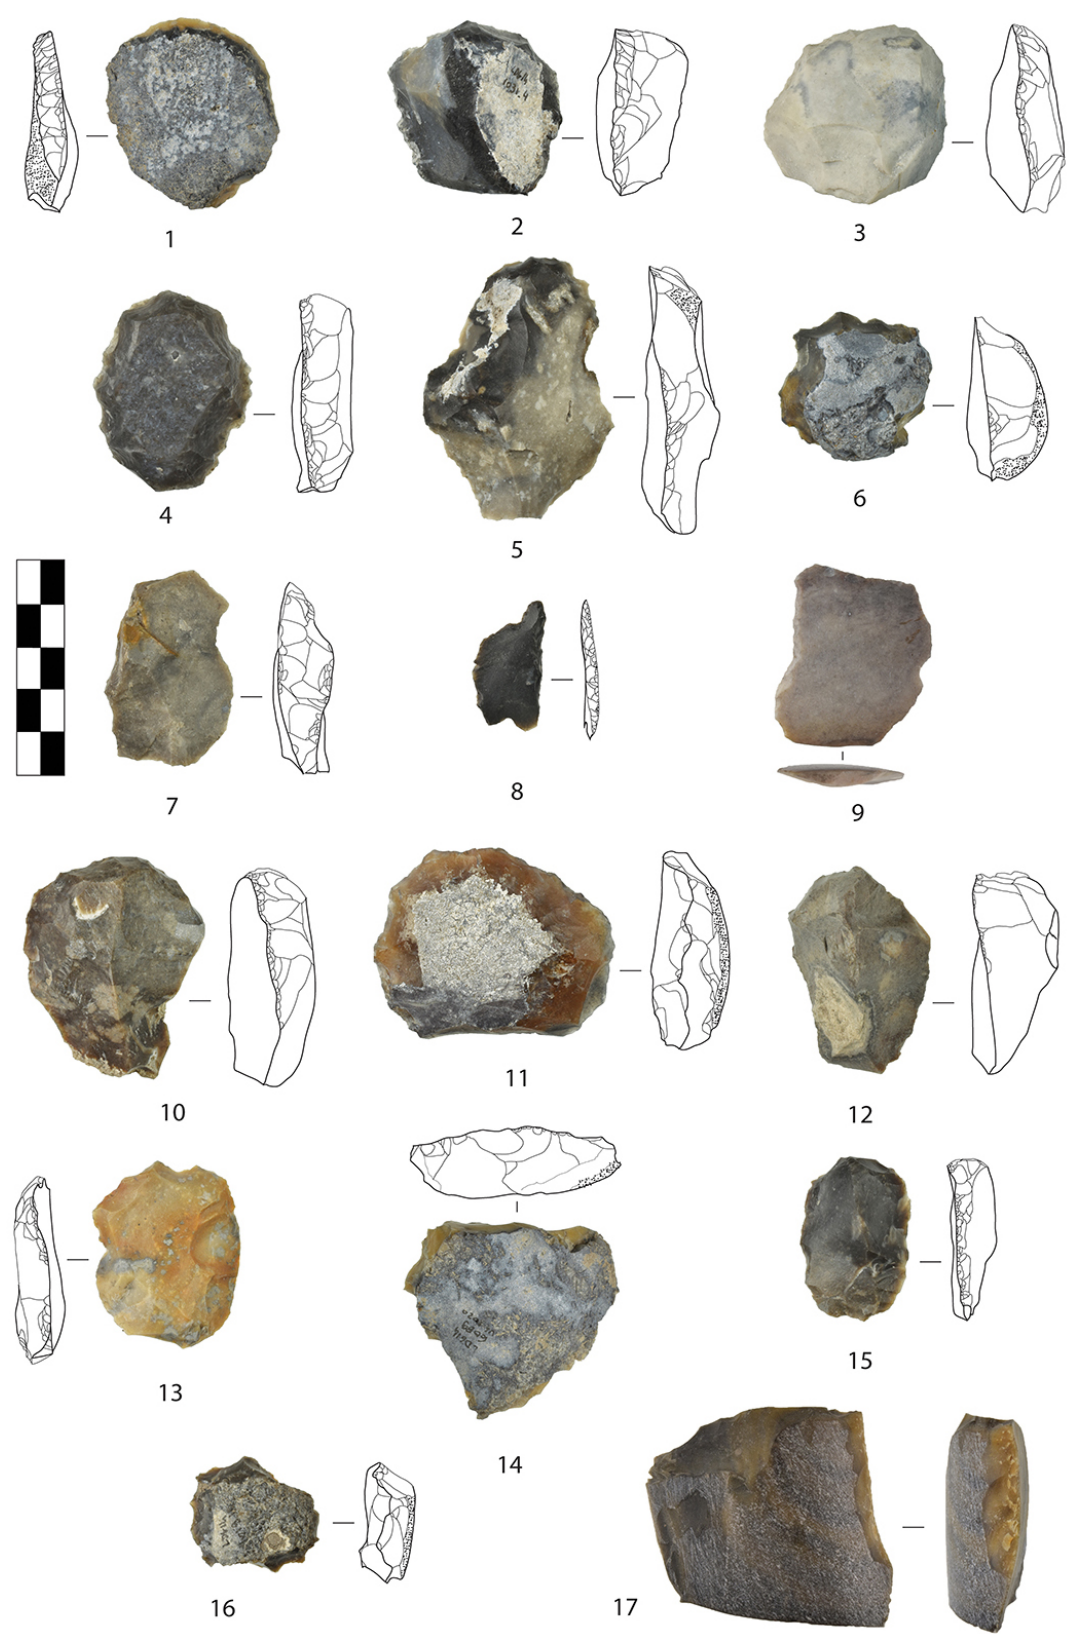
Figure 7. Tool assortment of LDG Middle Neolithic 1 to 9: 1 to 5 scrapers, 6 denticulate, 7 notched piece, 8 borer, 9 polished axe fragment retouched; Late Neolithic tools 10 to 17: 10 to 15 scrapers, 16 denticulate, 17 retouched polished axe